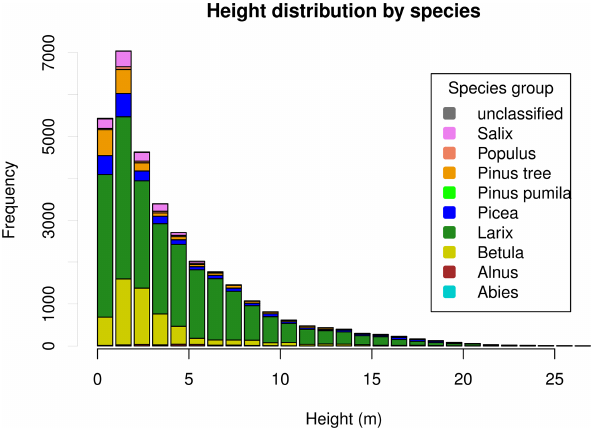
Figure 4. Height distribution of all trees on plots.